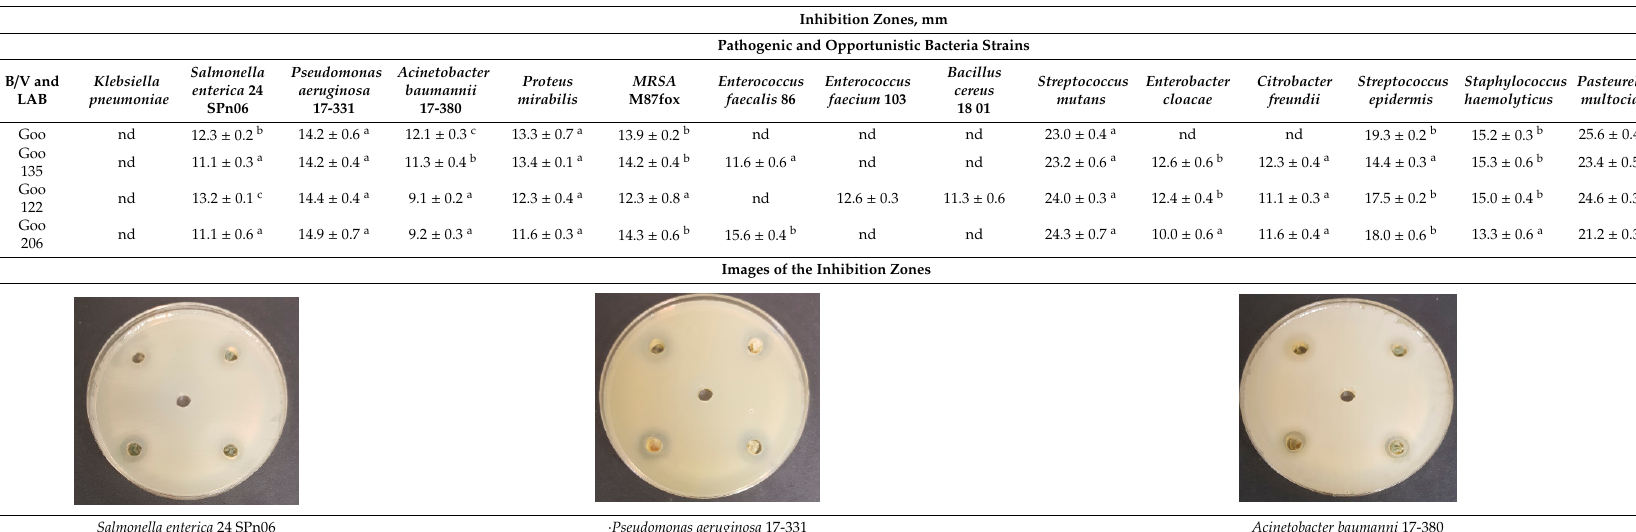
Table 1. Inhibition zones of gooseberries and the ones with Lactobacillus plantarum LUHS135, Lactobacillus plantarum LUHS122, and Lactobacillus faraginis LUHS206 fermented beverage combinations against pathogenic opportunistic microorganisms. Inhibition Zones, mm Pathogenic and Opportunistic Bacteria Strains